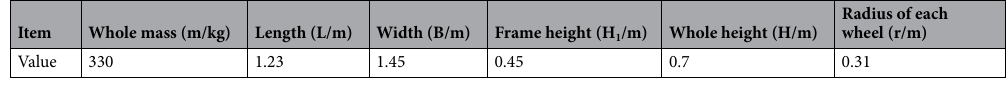
Table 1. Some key parameter of this UGV.